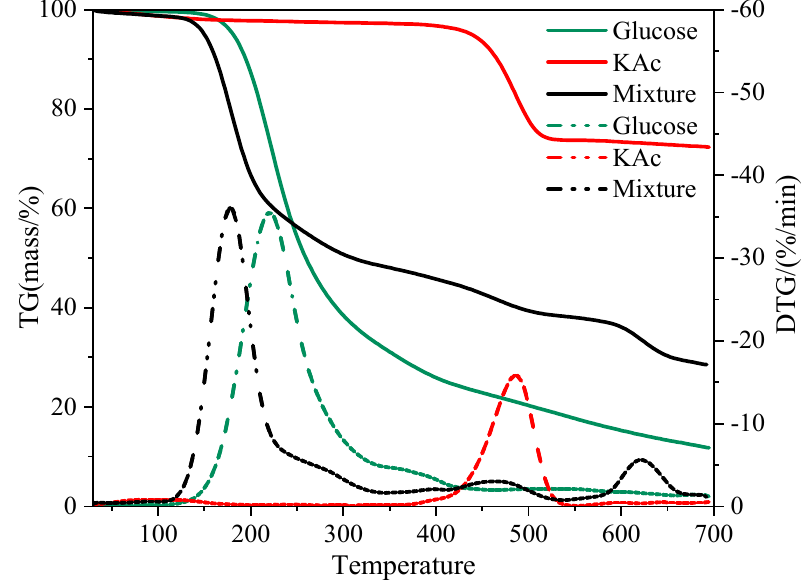
Figure 1. Thermogravimetric (TG) and differential thermogravimetric (DTG) profiles from the thermal decomposition of glucose, potassium acetate (KAc) and their (1:0.25 wt/wt) mixture at a heating rate of 40 °C /min. Table 1. Characteristics of the thermogravimetric curves.